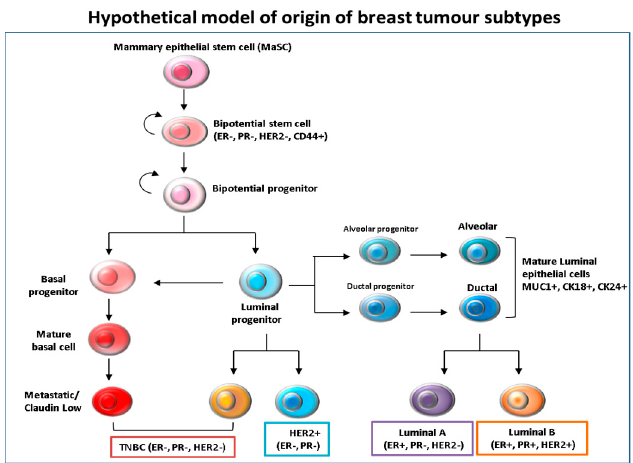
Figure 1. Hypothetical model of the origin and differentiation of breast cancer subtypes. It is believed that mammary epithelial stem cells (MaSc) represent the common cells of origin for all subsequent subtypes. The mammary stem cells then give rise to bi-potential stem cell progenitors, from which luminal and basal progenitor cells originate. The intermediate steps are driven by tumor subtype-specific transforming events that are still unclear. It is thought that basal progenitors can differentiate into basal claudin-low Triple negative/basal like (TNBC) subtypes, while luminal progenitors are likely to differentiate into both basal-like and luminal cells.